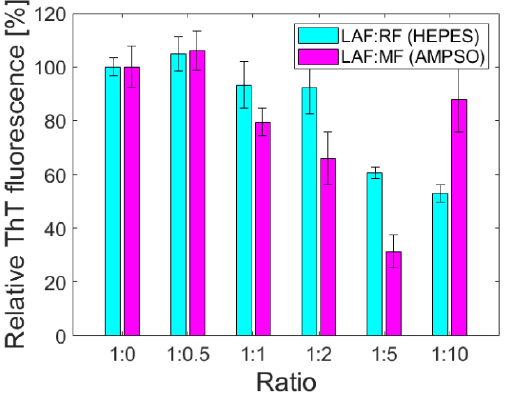
Figure 4. Concentration-dependent effect of ferritin derivatives on LAF monitored by ThT fluores- cence assay. Examination of the destructive effect of ferritin derivatives on LAF: (cyan) destruction of LAF in the presence of RF with LF 144; (magenta) destruction of LAF in the presence of MF with LF 160. Concentration of LAF was fixed, 2 mg/mL.